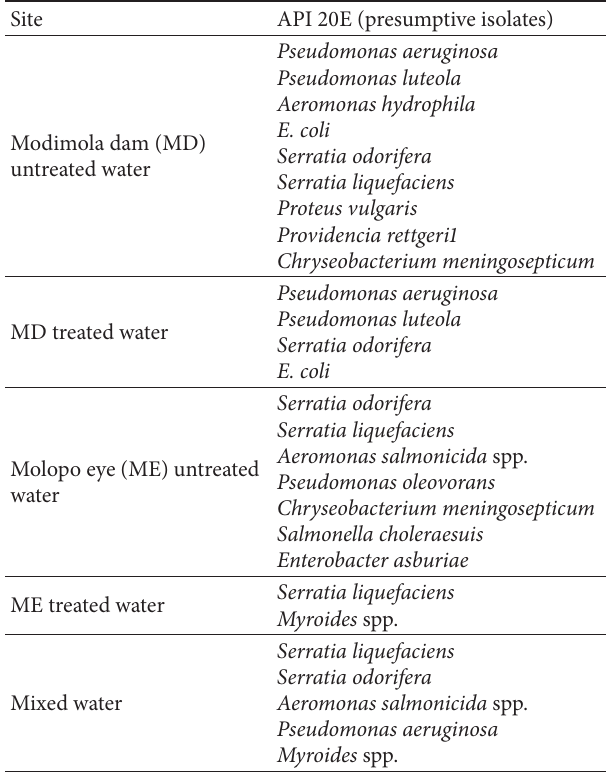
Table 4: Identification of the isolates from the treated (drinking) and source water using biochemical